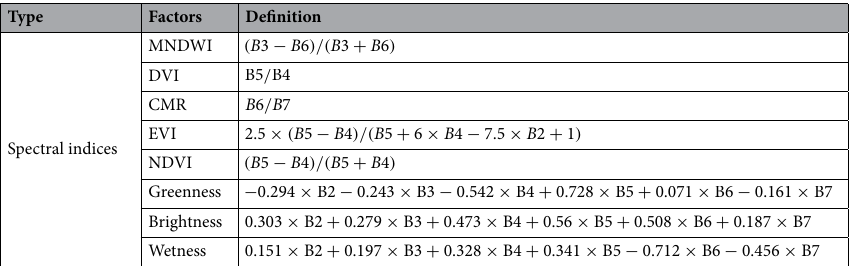
Table 1. Spectral indices used for assessment of the concentrations of Cu, Pb, and As in the soils.